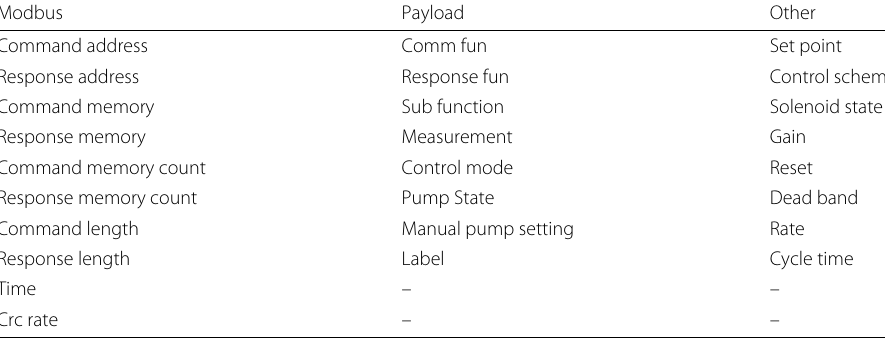
Table 1 The contents of the MSU